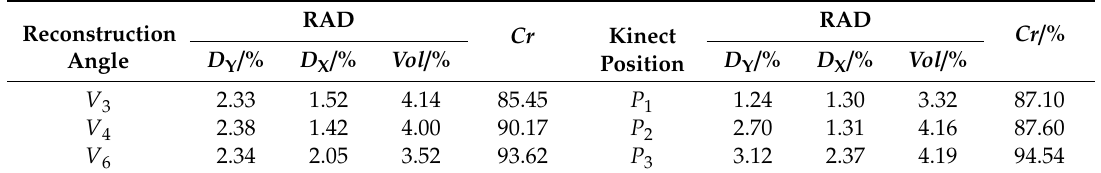
Table A2. Analysis of the morphological measurements of the SSBs (at various AOVs and in various